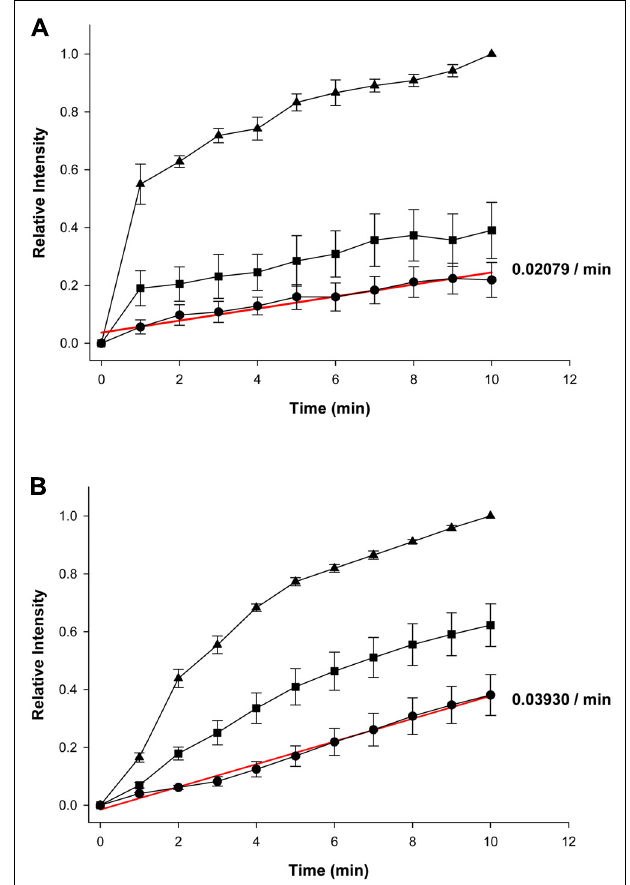
FIGURE 2 | Summary plots of fluorescence intensity versus time. (A) Summary of averaged and normalized control ( n = 6 experiments) and (B) 5 mM 4-PB data ( n = 4 experiments). First (source) cell ( (cid:2) ), second cell ( (cid:2) ), and third cell ( • ). Error bars are representative of SE. Solid red lines correspond to the first-order regressions with r 2 = 0.94 and r 2 = 0.99 for control and 4-PB treated cells,